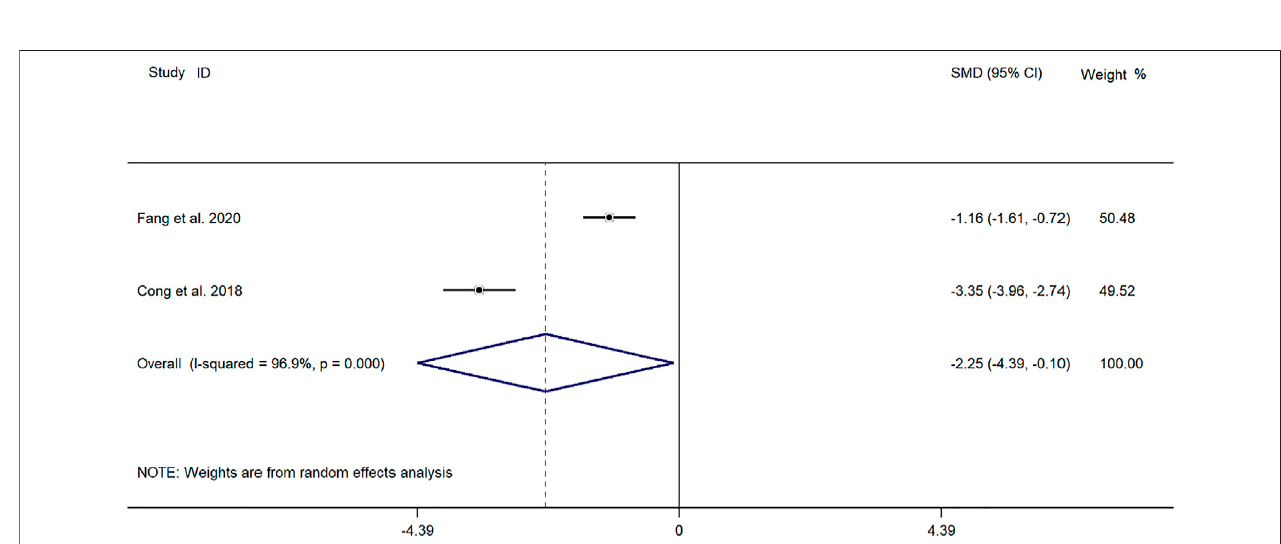
FIGURE 4 | Meta-analysis forest plot comparing the time for relief of cough in the experimental and control group.